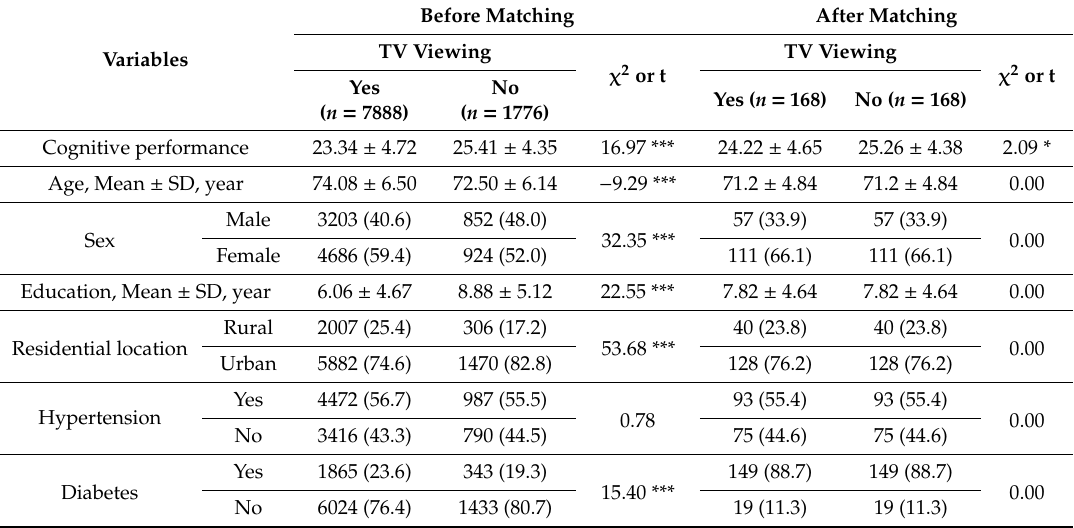
Table 2. Descriptive statistics of Korean older adults by TV